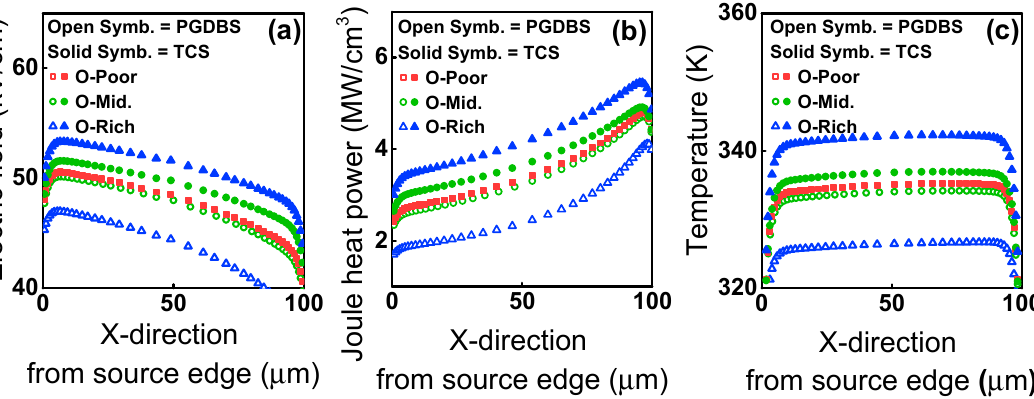
Figure 8. The simulated ( a ) electric field, ( b ) Joule heat power, and ( c ) temperature of the device based on the configuration of V GS /V DS .